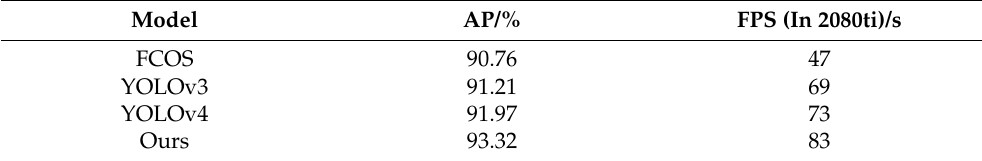
Table 4. Model comparison experiment.